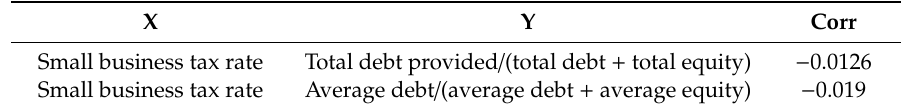
Table 5. Correlation coe ffi cients (X–Y).